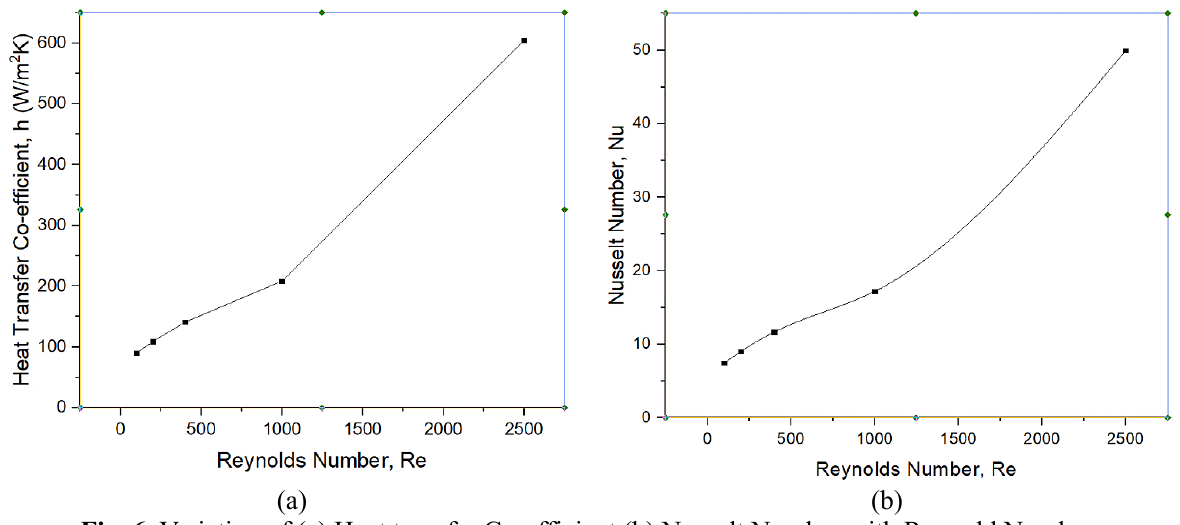
Fig. 6 . Variation of (a) Heat transfer Co-efficient (b) Nusselt Number with Reynold